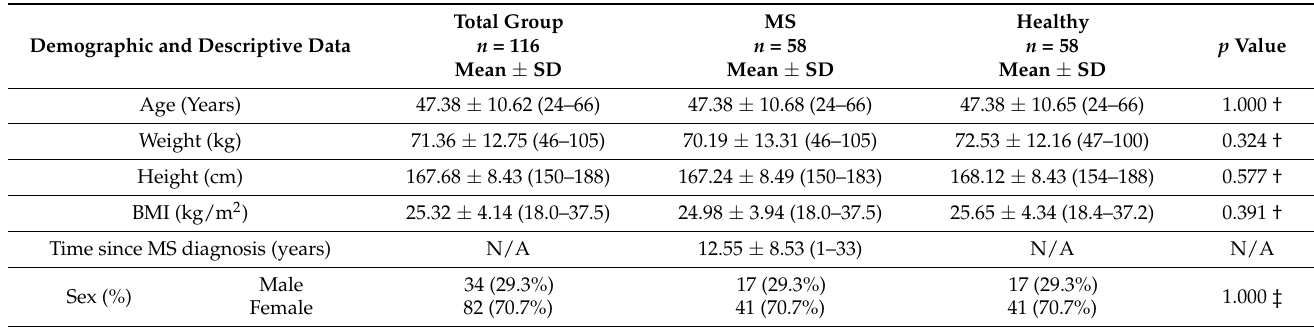
Table 1. Descriptive and socio-demographic data of the sample.